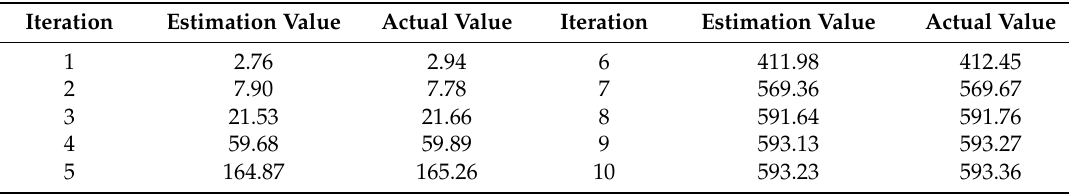
Table 2. Estimation value of Gossip algorithm vs. actual